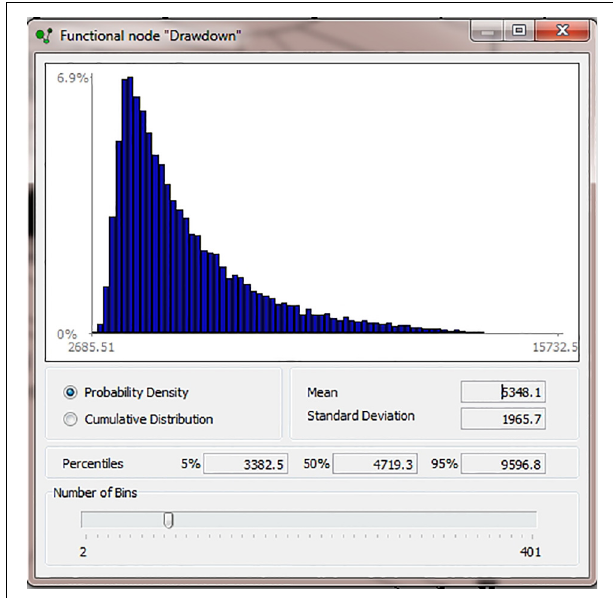
FIGURE 4 | Example of UNINET BBN output: September 17, 1996 explosion uncertainty analysis for Drawdown node (in m). Robertson et al. (1998) estimated drawdown to have been 4.5 ± 1.3